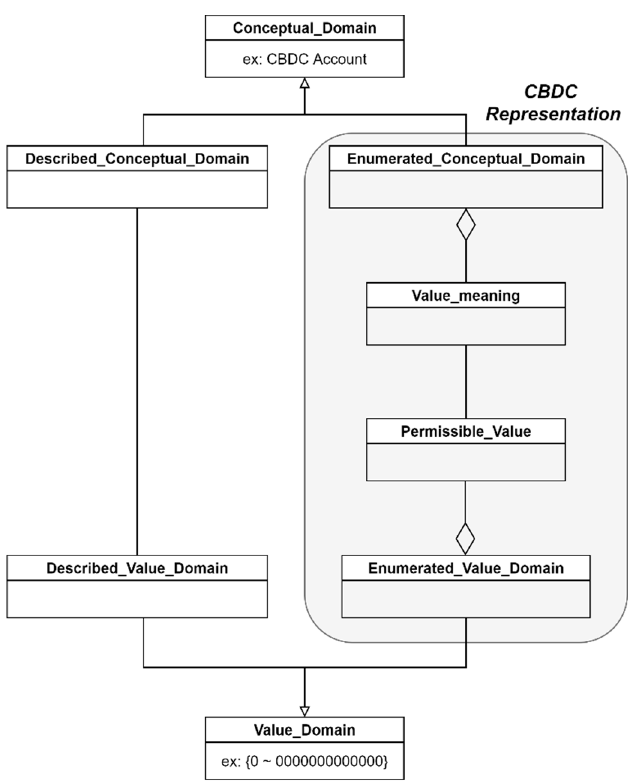
Figure 4. Conceptual Domain and Value domain example of MDR.